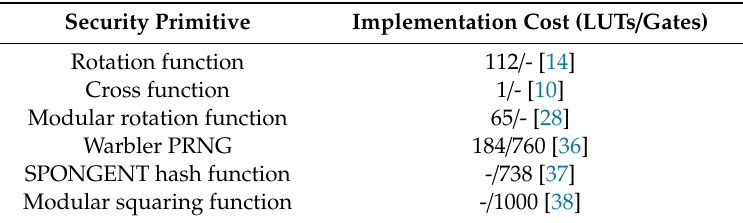
Table 7. The hardware implementation cost of the security primitives.